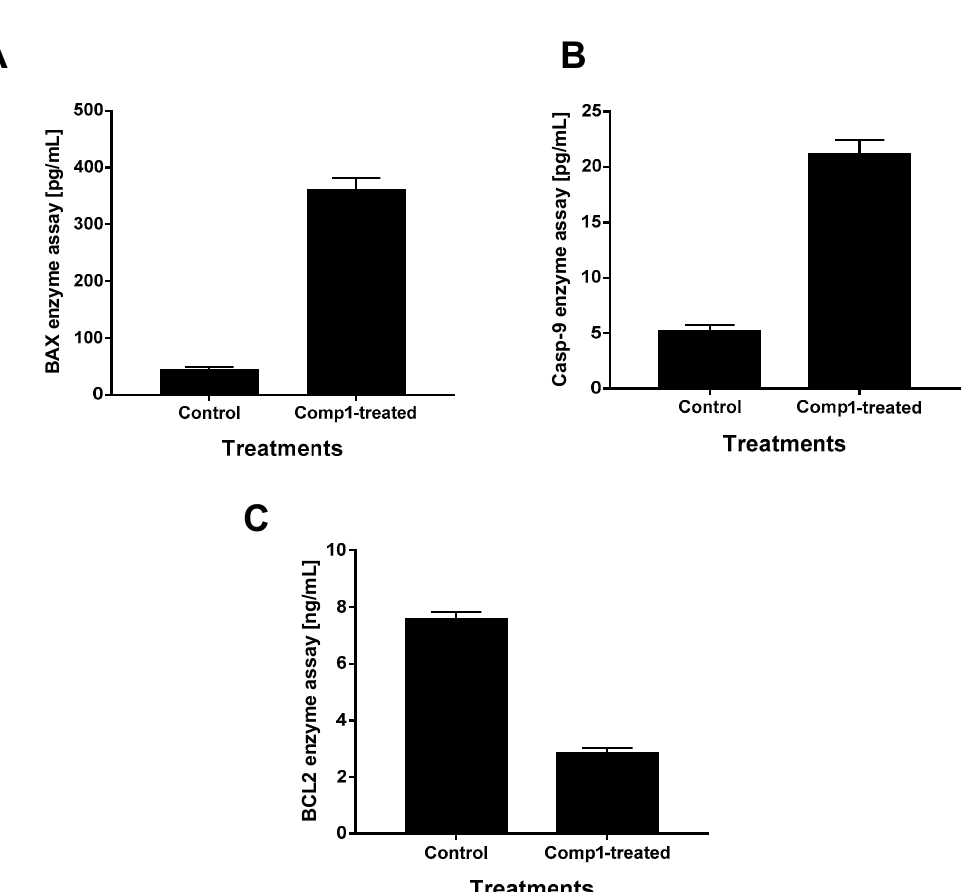
Figure 6. Enzymatic ELISA assays for apoptotic markers; ( A ) BAX, ( B ) caspase-9, and ( C ) BCL2 enzymes for both untreated and compound 1 -treated MCF-7 cells (IC 50 = 4.26 µ M, 48 h). Data illustrate the average of three independent experimental runs.